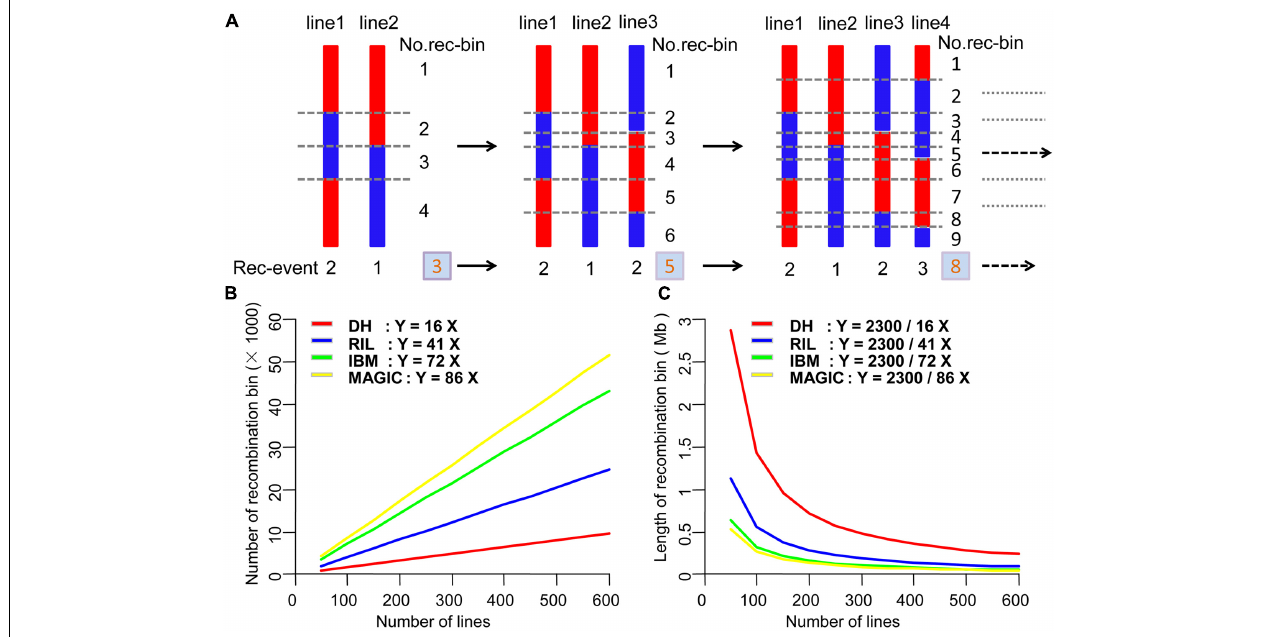
FIGURE 5 | Estimation of theoretical number and size of recombination bins in four types of population. (A) Relationship between the number of recombination events and recombination bins. (B) Theoretical number of recombination bins in different numbers of DH, RIL, IBM, and MAGIC lines. (C) Theoretical length of recombination bins in different DH, RIL, IBM, and MAGIC lines. DH, double haploid; RIL, recombination inbred lines; IBM, intermated B73xMo17; MAGIC, multi-parent advanced generation